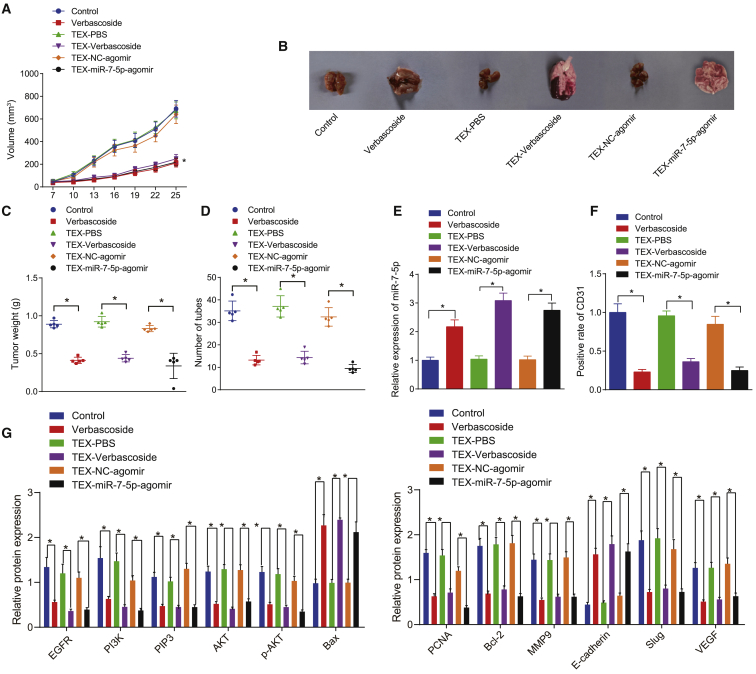
VB promotes the delivery of miR-7-5p by exosomes and inhibits the tumor formation and metastasis in miceNude mice were treated with VB, TEX from VB-treated GBM cells, or TEXs from miR-7-5p-agomir-treated GBM cells. (A) Tumor volume was measured. (B) Representative images of tumorigenesis and lung metastasis in mice. (C) Statistical chart of tumor weight of mice. (D) The number of pulmonary metastases in mice. (E) The expression of miR-7-5p in tumor tissues was detected by qRT-PCR. (F) The positive expression of CD31 protein in tumor tissues was detected by immunohistochemistry. (G) The protein expression of EGFR, PI3K, PIP3, Akt, p-Akt, Bax, PCNA, Bcl-2, MMP9, E-cadherin, Slug, and VEGF in tumor tissues was detected by western blot analysis. Data were shown as mean ± standard deviation of three technical replicates. ANOVA of repeated measurement was used for data comparison in (A). Unpaired t test was used for data comparison between two groups and one-way ANOVA for data comparison among multiple groups, with Tukey’s post-test test. ∗p < 0.05, compared with the corresponding control group.